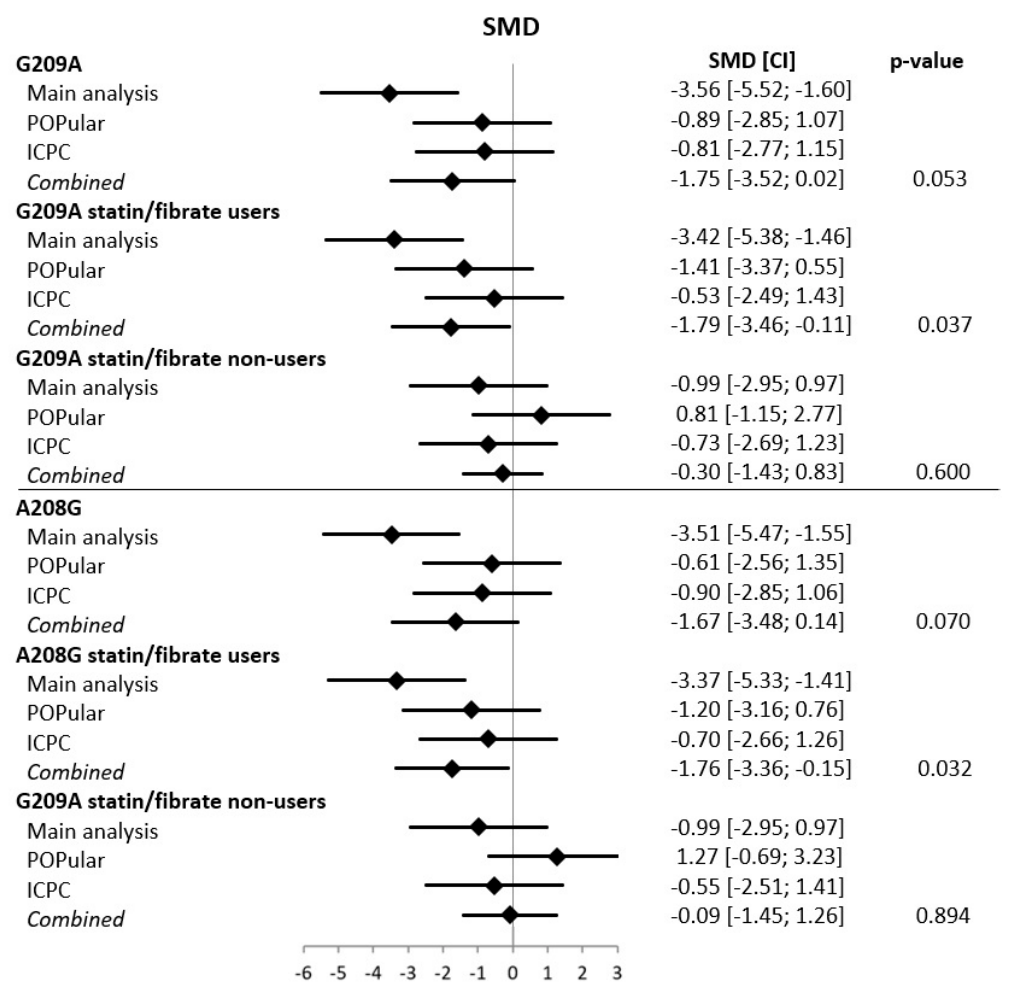
Figure 2. Meta-analysis for G209A and A208G variants in the main analysis and the POPular and ICPC validation cohorts. CI = confidence interval, SMD = standardized mean difference. For the meta-analysis, a random effects model was used.